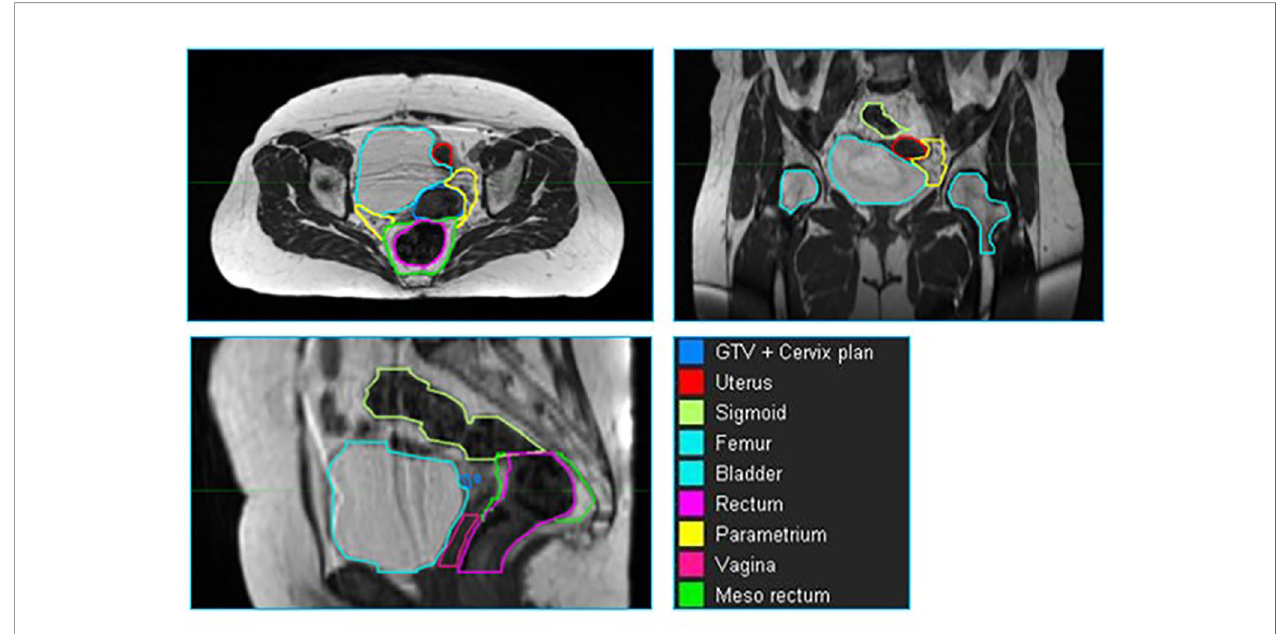
FIGURE 1 | An example of a cervix case provided to the neural network for training. The individual volumes are depicted in different